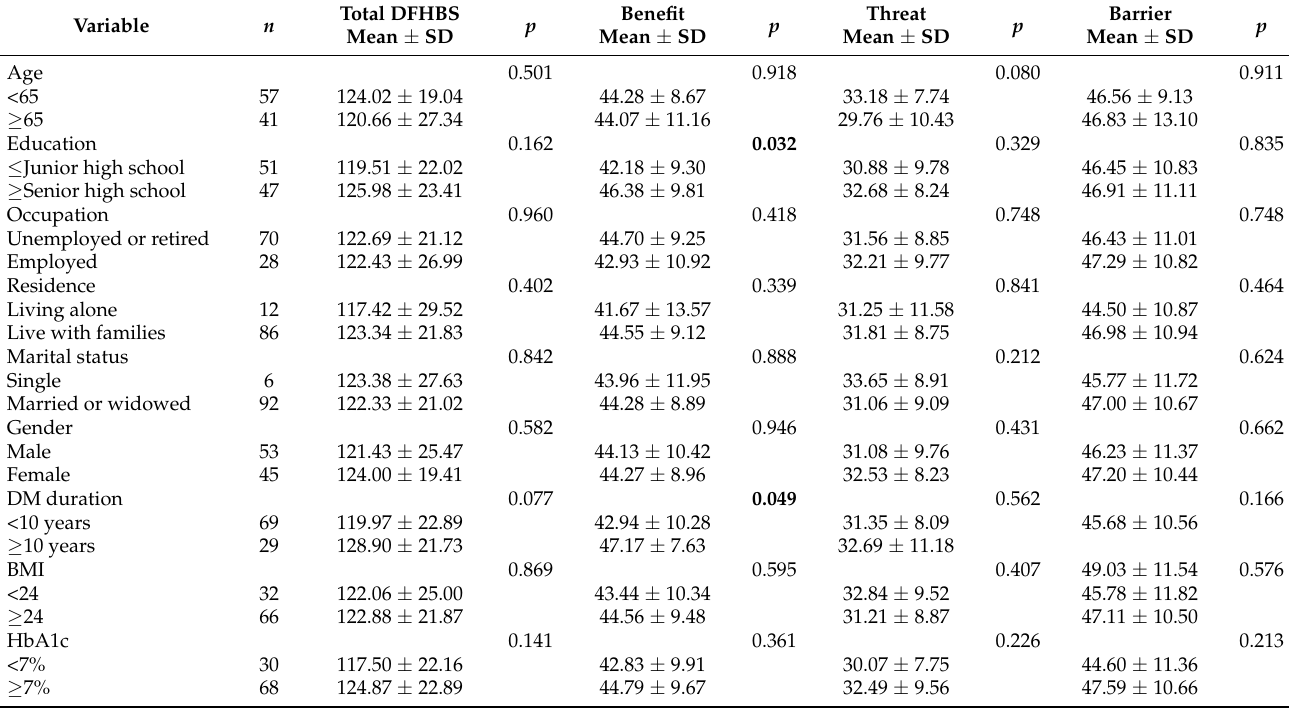
Table 2. Disparities of Health Beliefs (DFUHBS), among demographic and disease attribute